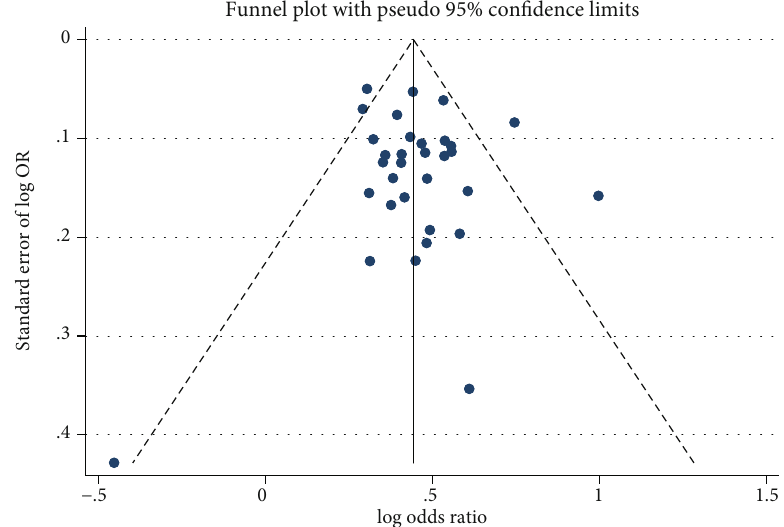
Figure 4: Publication bias for the analysis of association of STAT4 rs7574865 polymorphism and SLE susceptibility in overall populations.